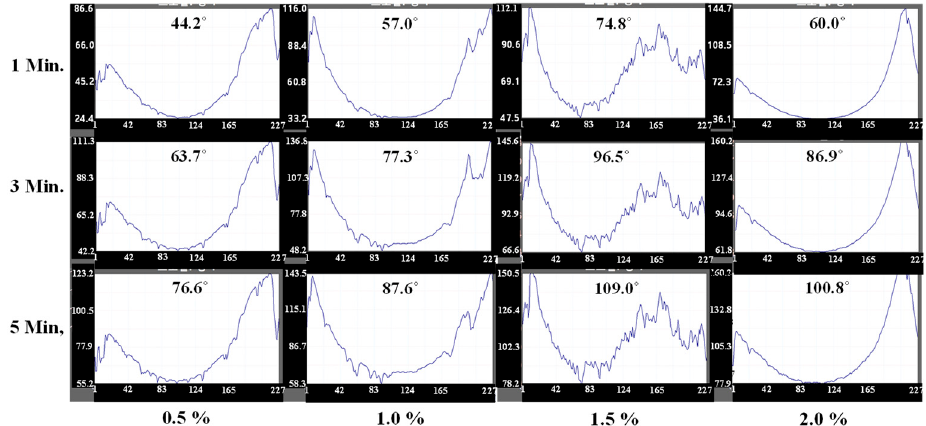
Figure 7. The waveforms of temperature distribution patterns along the vertical bisect lines: The vertical and horizontal axes represent temperature and pixel numbers from top to bottom of the vertical bisect line, respectively.